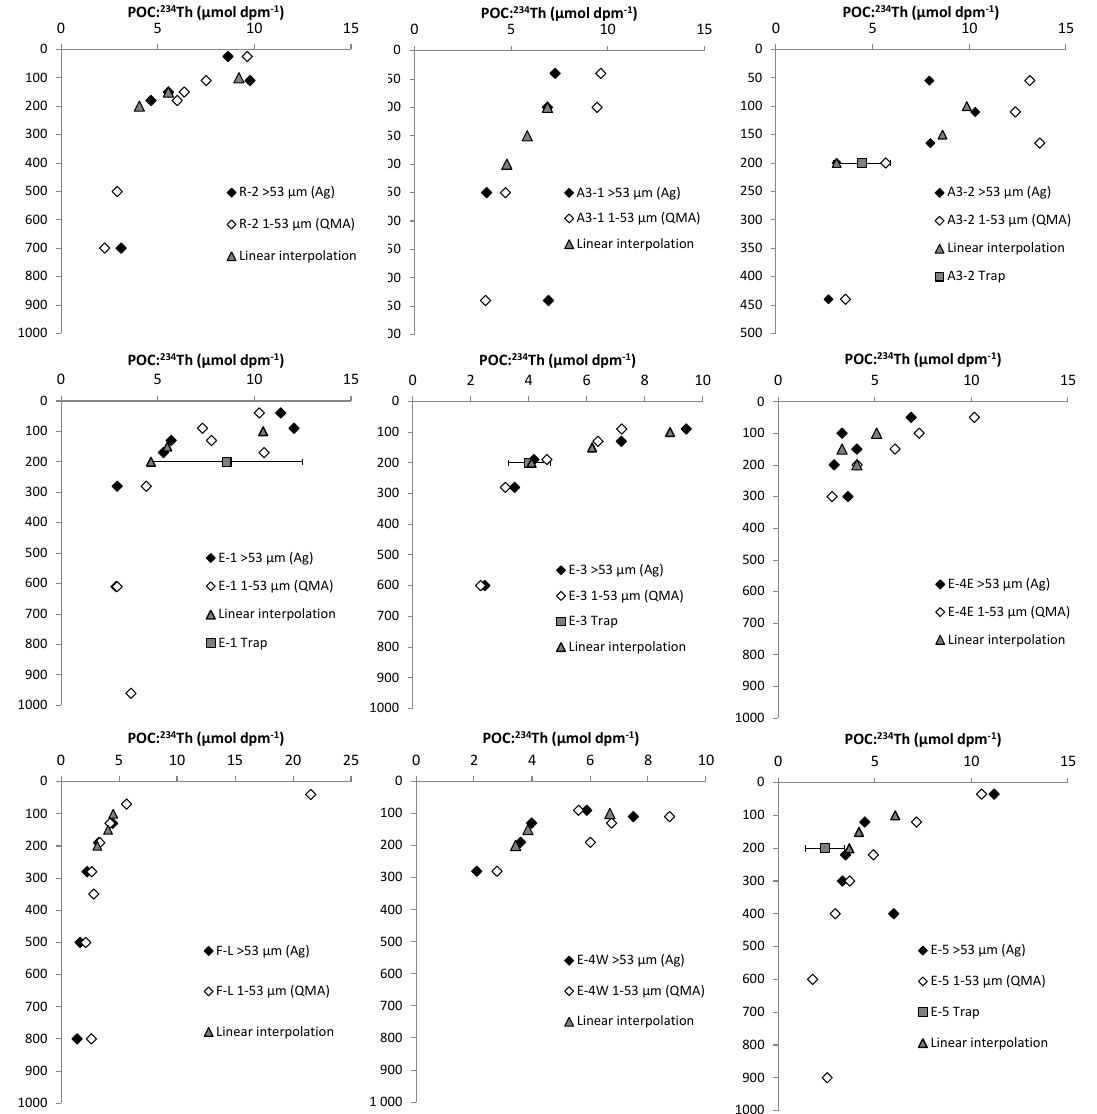
Figure 4. POC: 234 Th (C:Th) ratio in size-fractionated (1–53 and > 53µm) suspended particulate matter collected by ISP and comparison with sinking particles collected via sediment traps at 200m depth. Also, shown is a linear interpolation of C:Th ratios at 100, 150, and 200m depth for carbon flux estimates. Linear interpolation was obtained using a straight line fit between the upper and the lower data point relative to the target depth (i.e., 100, 150, and 200m